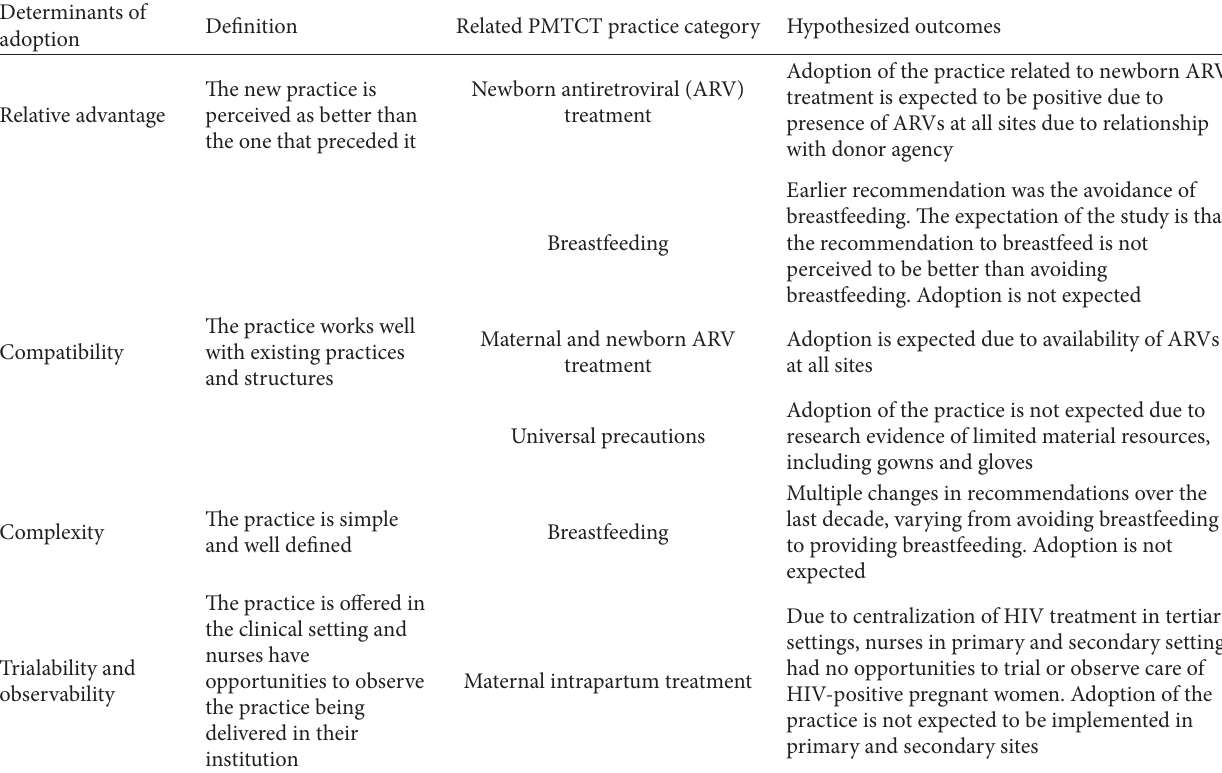
Table 2: PMTCT practice items related to determinants of